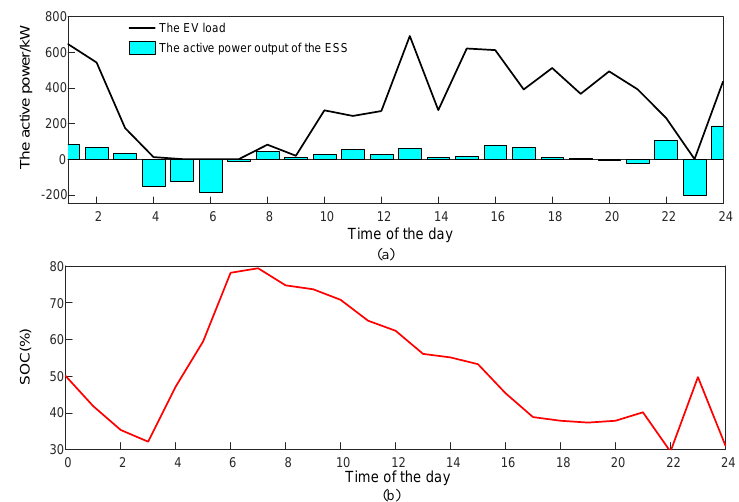
Figure 11. ( a ) Voltage curves of node 18 under different cases in a day. ( b ) Differences between actual and reference voltages under different cases in a day.